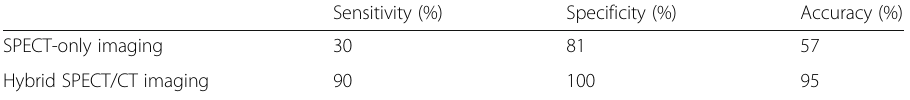
Table 4 Diagnostic accuracies of SPECT-only imaging and hybrid SPECT/CT imaging Sensitivity